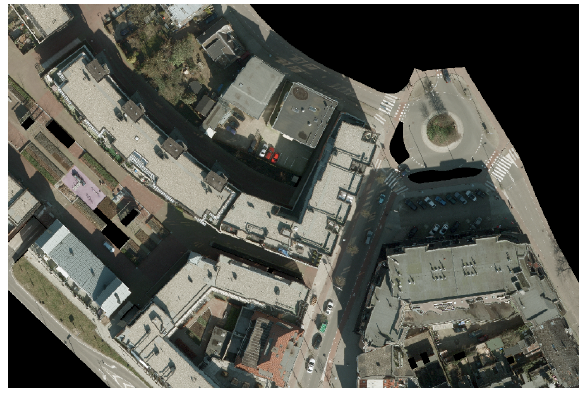
Figure 10: Ortho image 2010